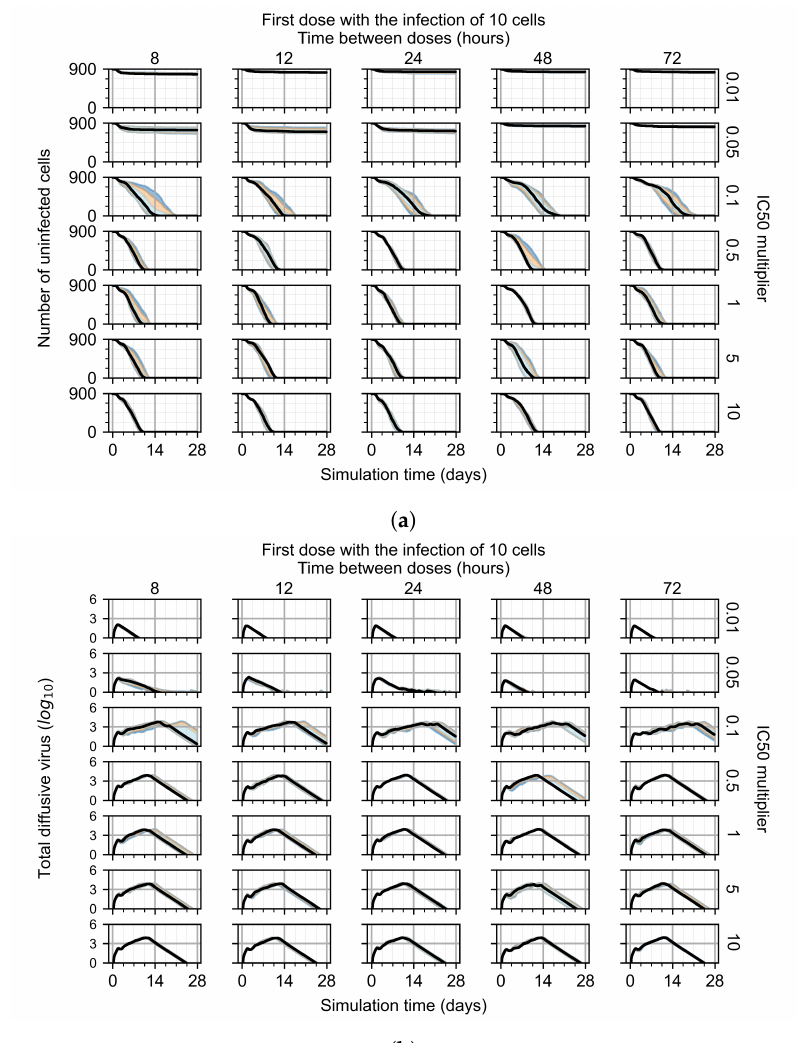
Figure 6. Coarse-parameter investigation (10 replicas of the treatment simulation). Treatment starts with 10 infected cells. For all subfigures, the median measurement of simulation replicas is the black line, the 0th to 100th quantiles are shaded as dark blue, 10th to 90th shaded in orange, and 25th to 75th as light blue. Treatments with an IC 50 multiplier < 0.055 contain the infection, while treatments with IC 50 multiplier ≥ 0.05 do not. The top two rows show a reduction in viral load due to treatment, while in the lower two rows the decrease is due to all cells being dead. ( a ) Uninfected cell population. ( b ) Extracellular diffusive virus; y -axis in log scale, and exponent values as tick